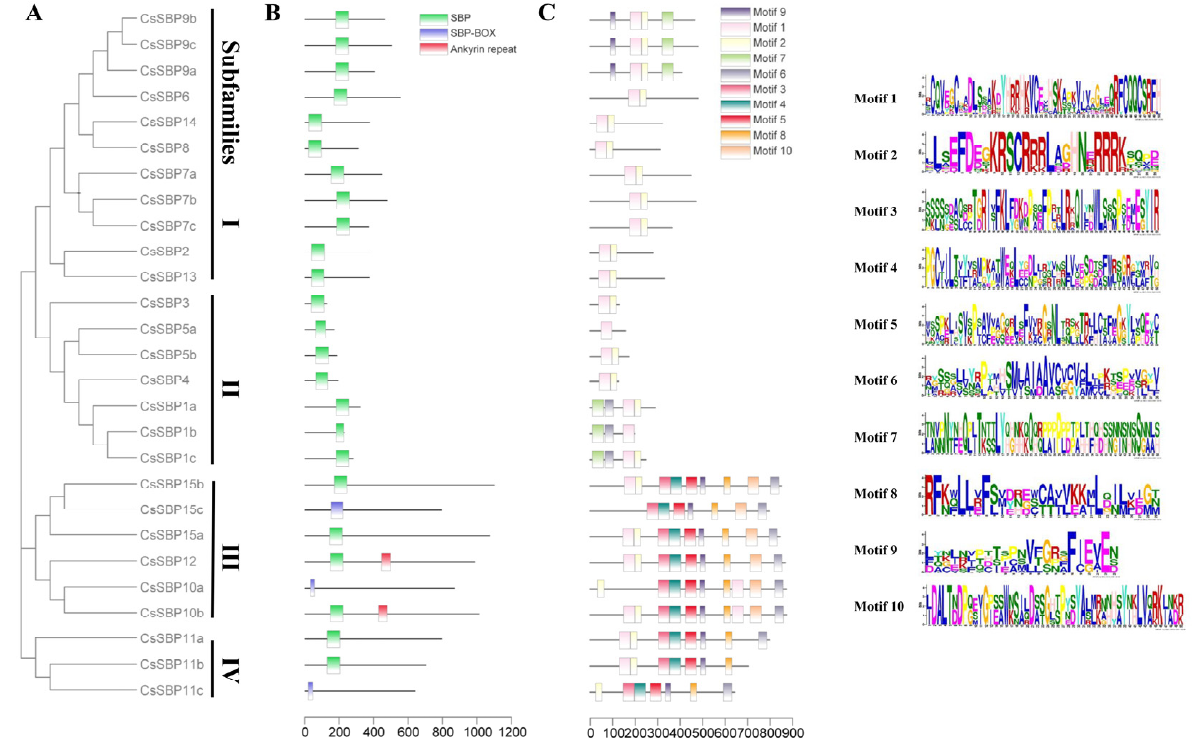
Figure 5. Phylogenetic relationships and protein structure of sweet orange CsSBP protein. ( A ) Neighbor joining trees constructed for CsSBP. ( B ) Conserved domains. Different domains are represented in different colors. ( C ) Protein motif. Schematic diagram of the conserved motifs of SBP proteins in sweet orange, which were elucidated using MEME. Each motif is represented by a number in the colored box. Logo of each motif is on the right side of the